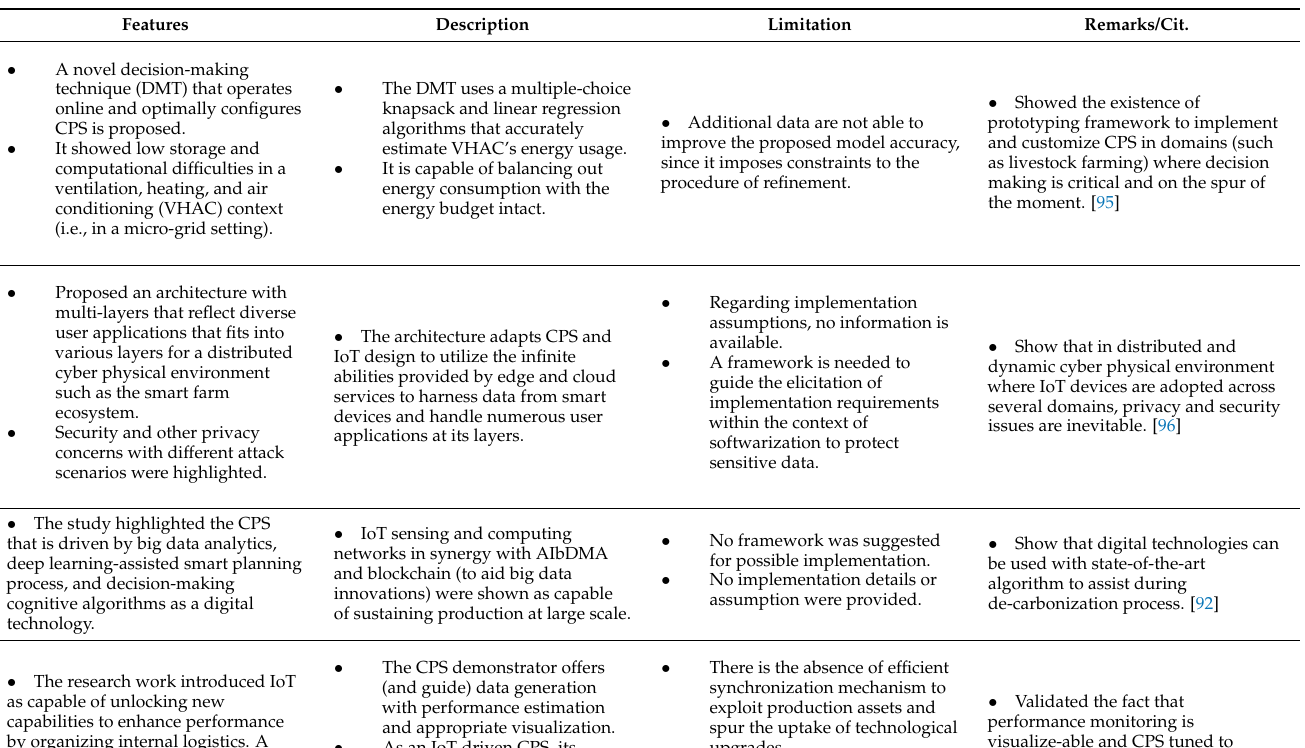
Table 6. Indicative comparison evaluation of current studies on